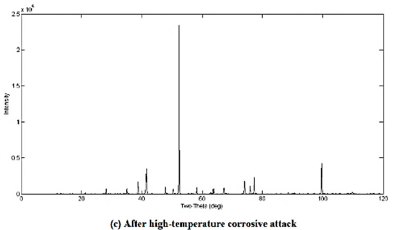
Figure A22. Qualitative XRD analysis of the surface of CS-Bare ( a ) before corrosive attack, ( b ) after low-, and ( c ) high-temperature corrosive attack.